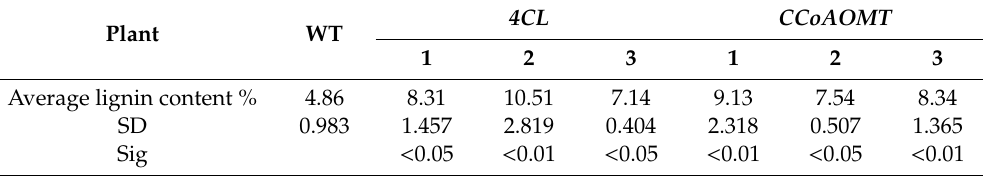
Table 3. Determination of the content of lignin in